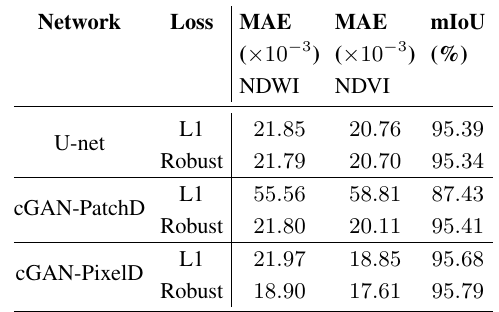
Table 3. The MAE results for NDWI and NDVI respectively, and the mIoU based on NDVI classification. The mIoU score is the average among all four